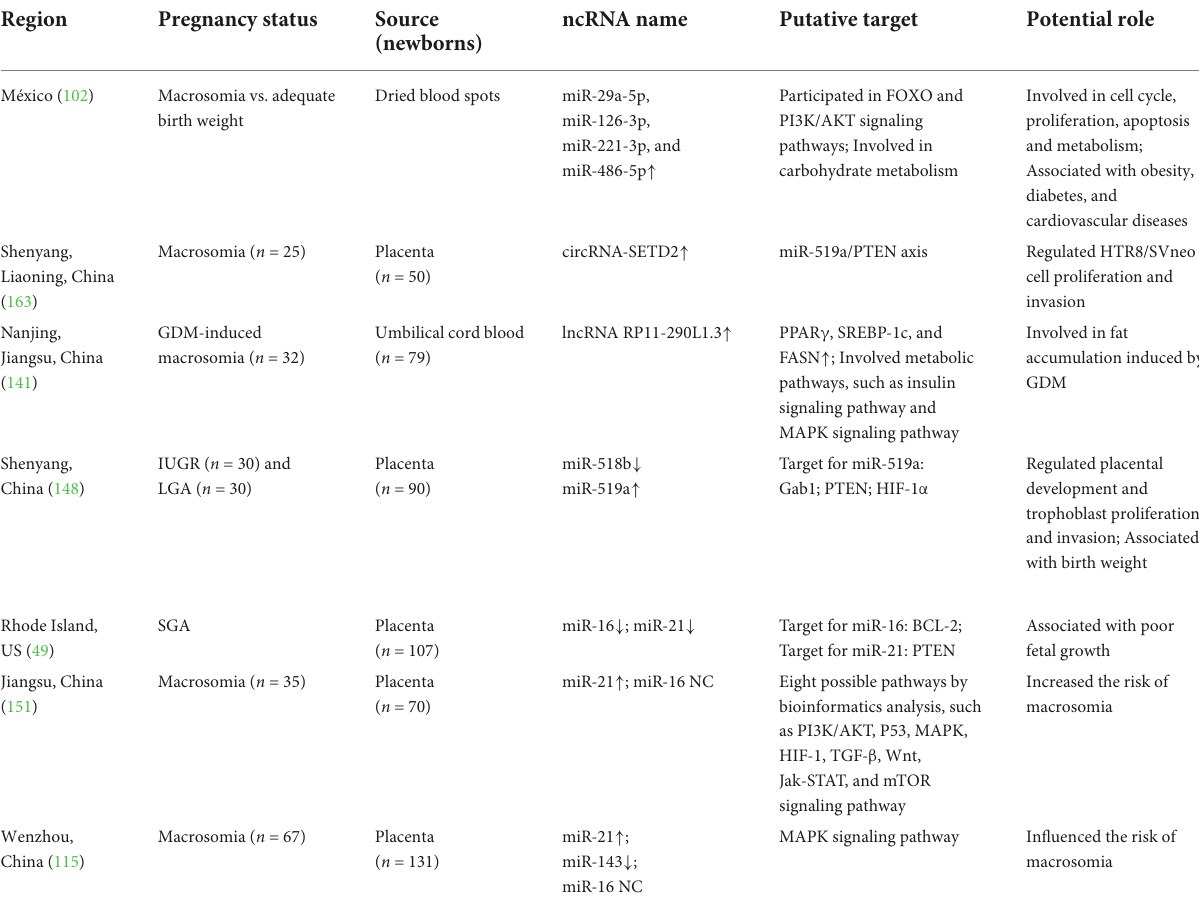
TABLE 2 ncRNA involved in influencing the birth weight of human